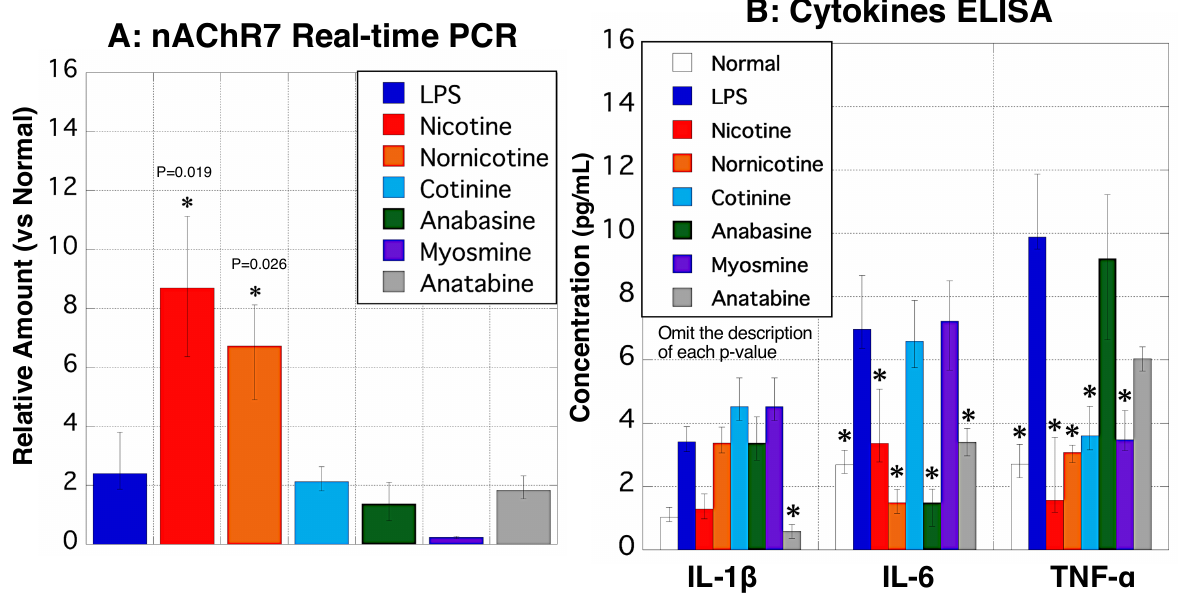
Figure 11. nAChR7 and cytokine expression in rat peritoneal M Φ . ( A ) Real-time PCR was performed to detect nAChR7 expression in M Φ . The y -axis shows the mRNA expression levels of nAChR7 in M Φ treated with 10 µ g/mL of LPS (blue), nicotine (red), nornicotine (yellow), cotinine (light blue), anabasine (green), myosmine (purple), and anatabine (gray), relative to normal conditions (no stimulation). ( B ) ELISA was performed to measure cytokine levels in rat M Φ . The y -axis indicates the concentrations of IL-1 β , IL-6, and TNF- α (pg/mL) in normal M Φ (white) or M Φ stimulated with 10 µ g/mL of LPS (blue), nicotine (red), nornicotine (yellow), cotinine (light blue), anabasine (green), myosmine (purple), and anatabine (gray). Data values are presented as the median ± max/min. * p < 0.05 (vs. LPS treated M Φ ). ELISA, enzyme-linked immunosorbent assay; IL-1 β , interleukin-1 β ; IL-6, interleukin-6; M Φ , macrophages; nAChR7, α 7 nicotine acetylcholine receptor; and TNF- α , tumor necrosis factor- α